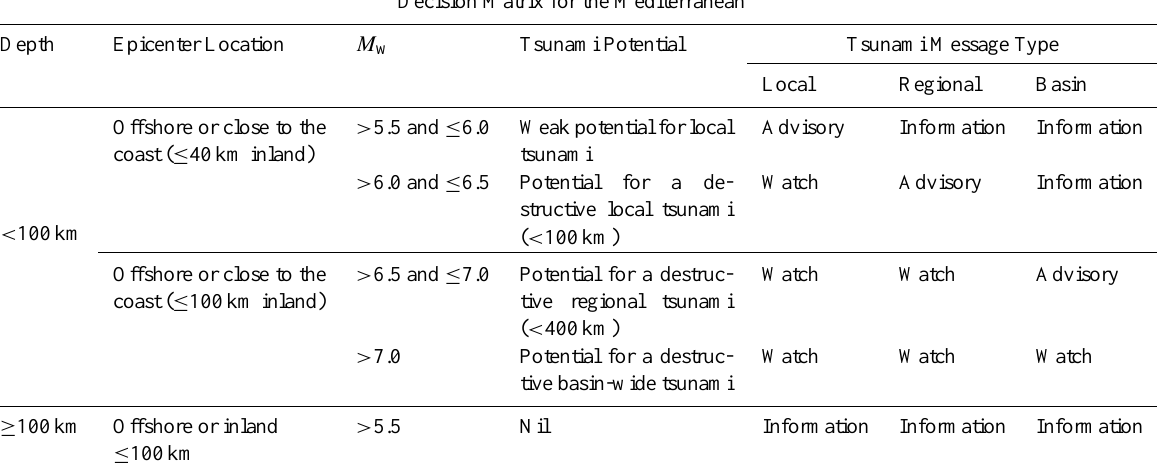
Table 2. Decision Matrix for the Mediterranean basin, proposed by the ICG/NEAMTWS in November 2010. Notice that no action is suggested when earthquakes with a depth less than 100km and with 5.5 <M w ≤ 6.5 are in the distance range between 40 and 100km, and for all earthquakes that are more than 100km inland.